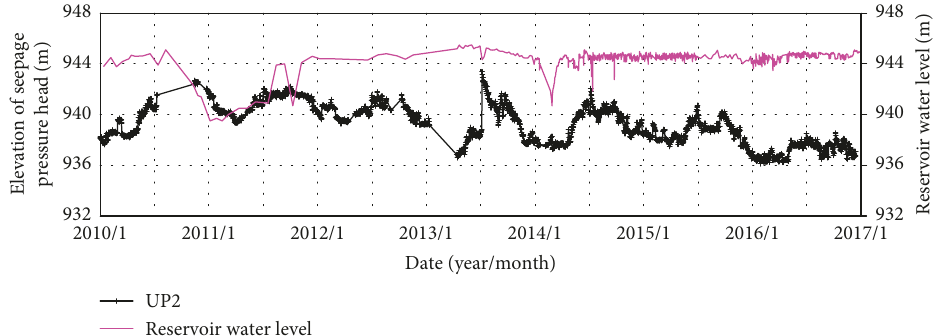
Figure 6: Time series for seepage pressure head at UP2 and reservoir water level.